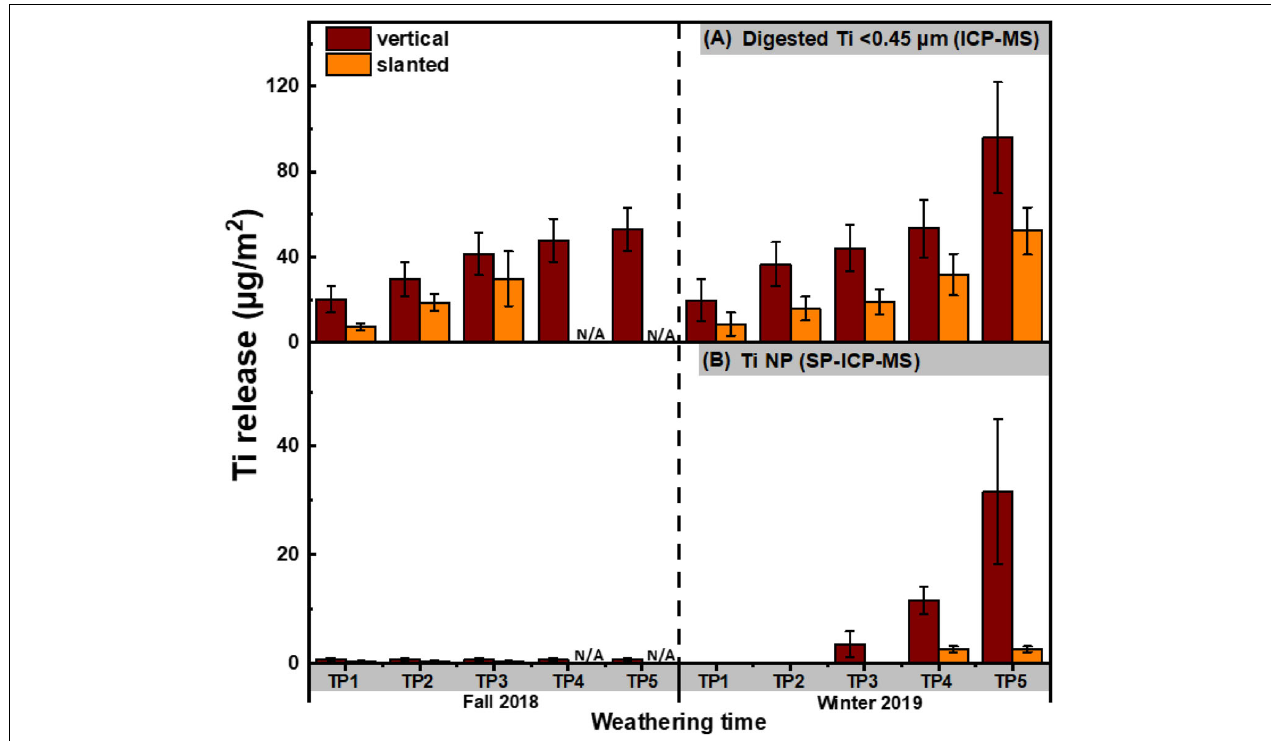
FIGURE 4 | Cumulative concentrations of sub-0.45- µ m Ti determined by (A) ICP-MS on acidified samples and (B) SP-ICP-MS, obtained by integration of the NP peaks. Ti was measured following its release from the stained surfaces in vertical and slanted exposure modes (N = 4 for each condition). Release was normalized by the surface area of the painted panels that were subject to weathering and corrected for the pre-existing natural background in the precipitation. Measurements were performed using a magnetic sector ICP-MS. N/A denotes two samples that were lost.